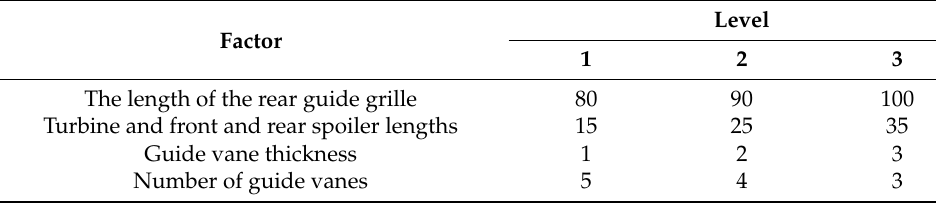
Table 7. Orthogonal experimental factors and